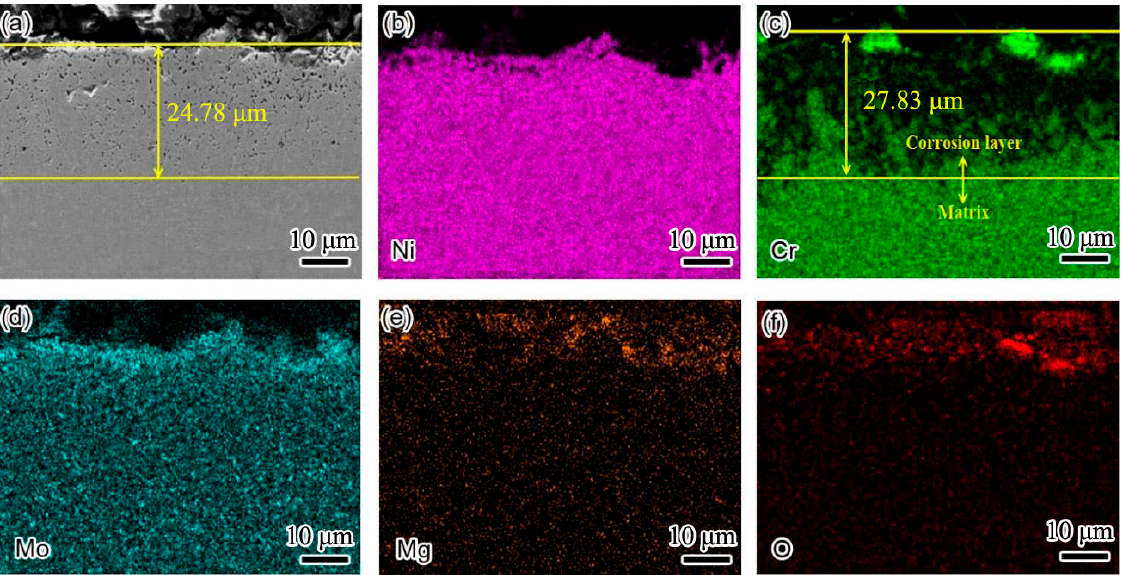
Figure 7. The cross ‐ sectional element distribution of the Inconel 625 weld cladding after corrosion for 10 h. ( a ) Cross section morphology of Inconel 625 weld cladding; ( b ) Ni element distribution; ( c ) Cr element distribution; ( d ) Mo element distribution; ( e ) Mg element distribution; ( f ) O element distribution